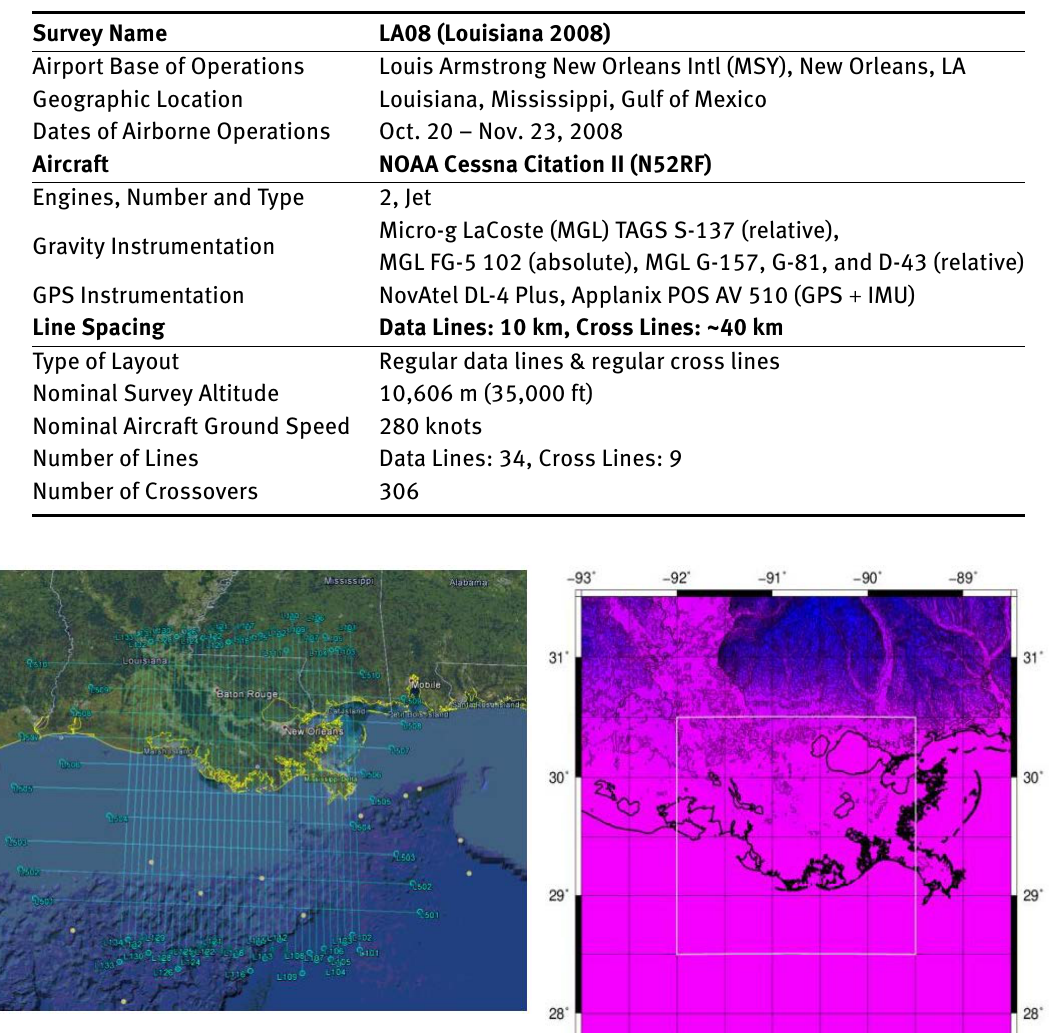
Table 1: Synopsis of survey layout and execution for Louisiana test area